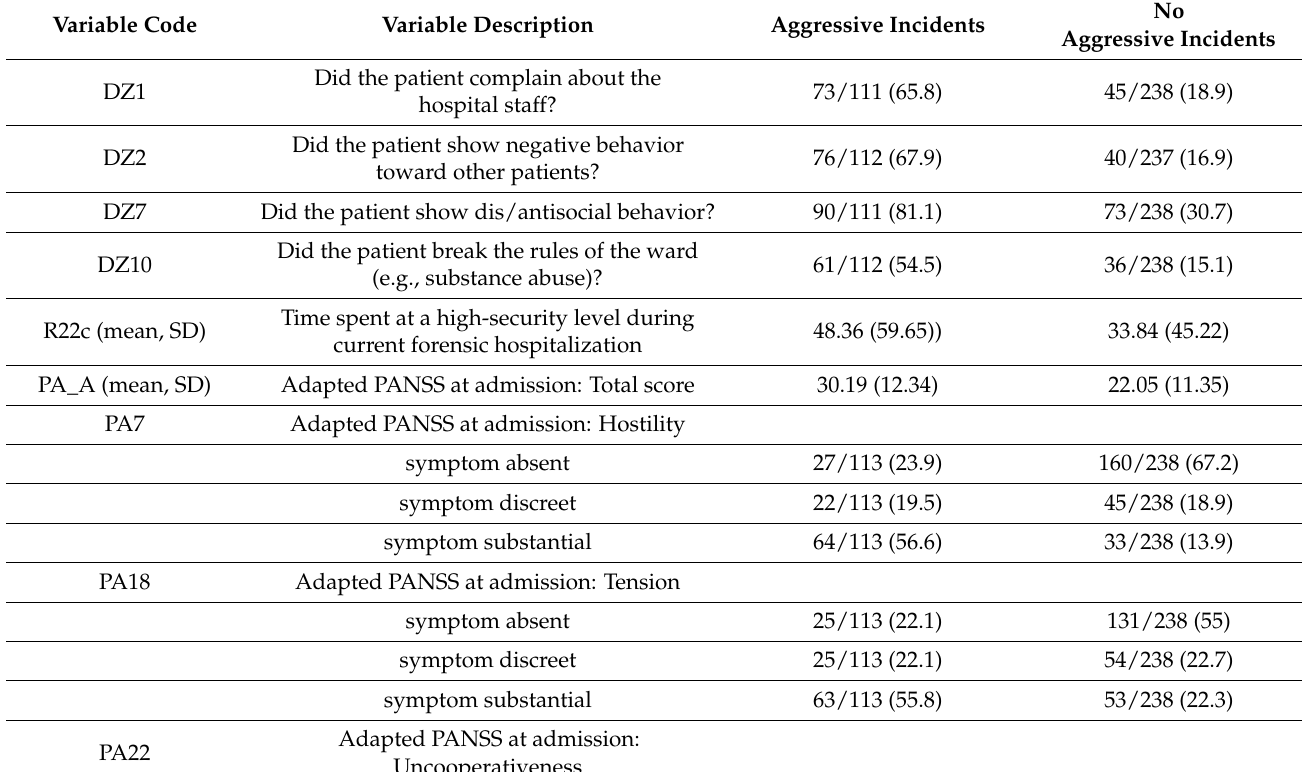
Table 3. Absolute and relative distribution of relevant predictor variables 1